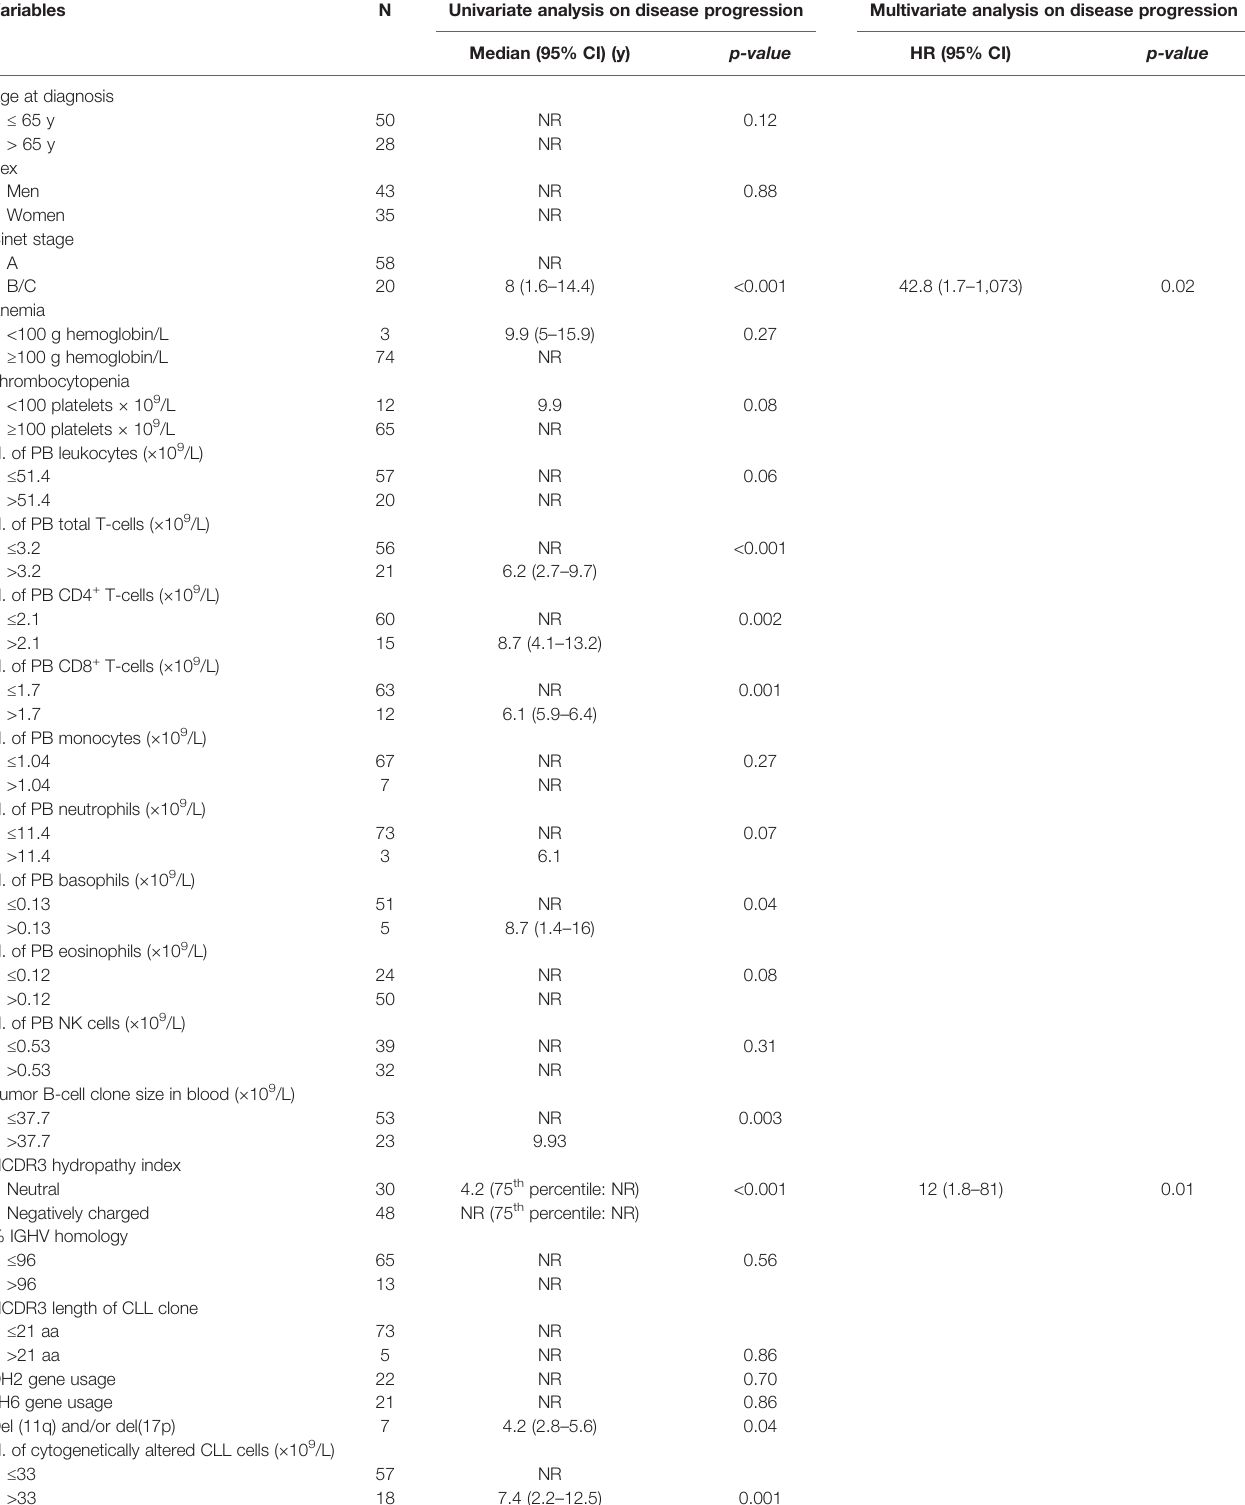
TABLE 3 | Univariate and multivariate analyses of prognostic factors with an impact on disease progression in M-CLL (N =